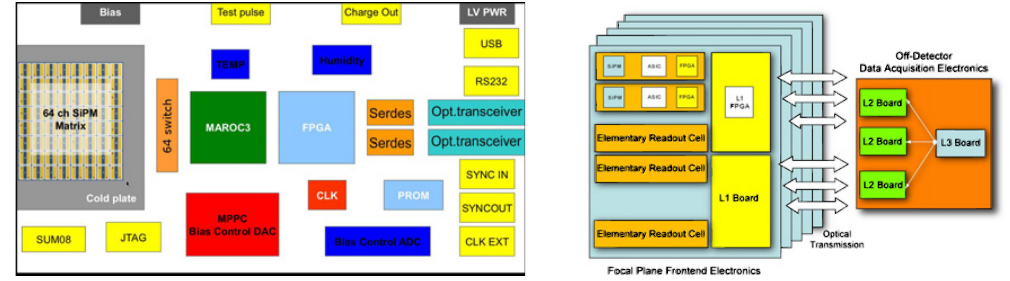
Figure 5. Left : layout of the frontend electronics to be used in FAMOUS. (LV PWR: power input - MAROC3, FPGA: see text - SERDES: serializer/deserializer - SUM08: analog sum outputs - JTAG: joint test action group (test port) - CLK: internal clock - PROM: programmable ROM - CLK EXT: external clock) Right : architecture of the data acquisition system. Each focal plane frontend electronics board offers 64 channels. The total system is modular